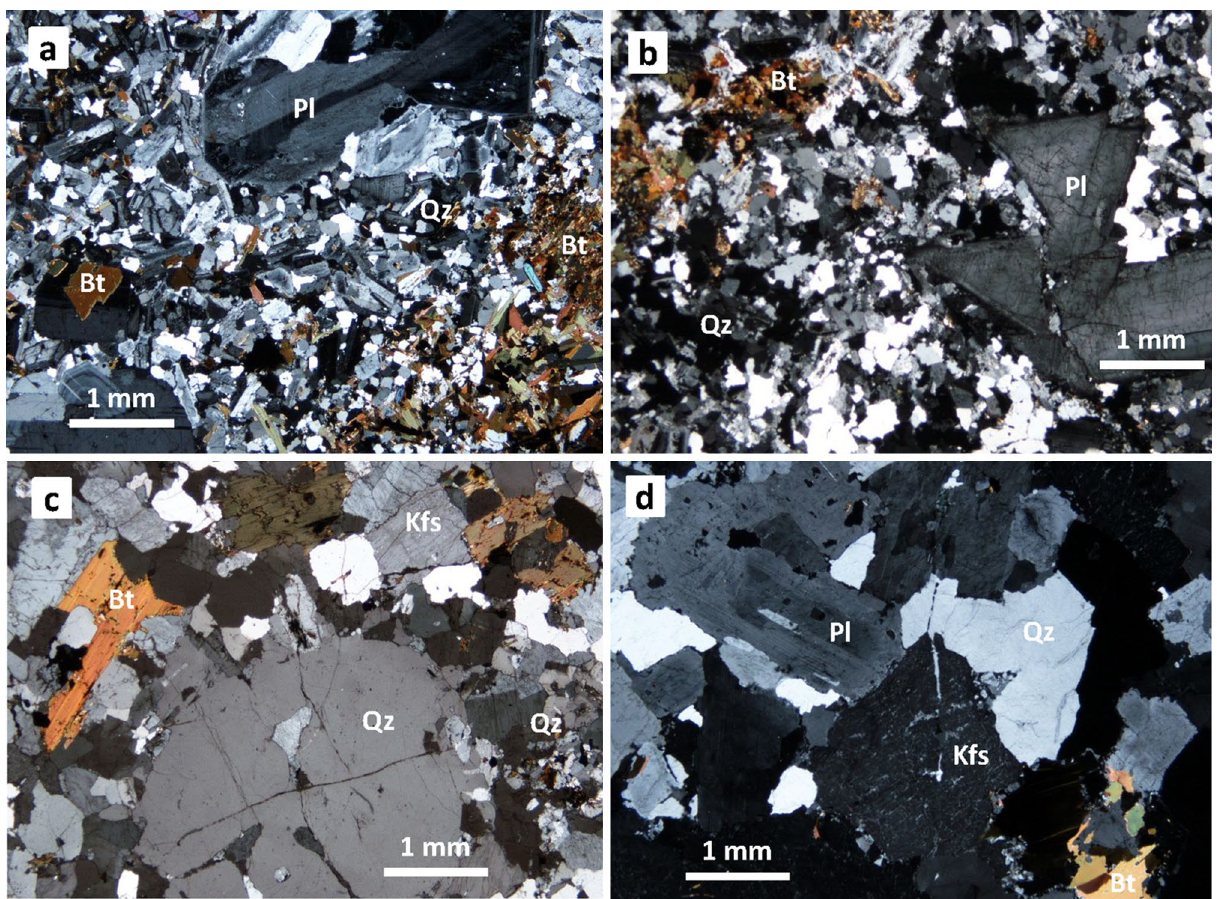
Figure 5. Photomicrographs of the Kurobegawa Granite ( a – c ) and a ~ 10 Ma granite ( d ) taken in cross- polarized light. ( a ) Typical porphyritic textures with micro crystals of quartz, plagioclase and biotite at the northwestern margin of the granite at Loc. KRB16. ( b ) Groundmass quartz shows a strong dynamic recrystallization and fracturing of a large plagioclase phenocryst near the Jiigatake Volcanics at Loc. KRB30. Many xenocrystic zircons were identified in this sample. ( c ) Groundmass quartz shows a weak dynamic recrystallization, and a quartz phenocryst shows dissolution at the south of the granite at Loc. KRB27. ( d ) Equigranular granite showing indications of neither tectonic shear nor fluid migration located to the west of the northern Kurobegawa Granite at Loc. KRB23. Qz quartz, Pl plagioclase, Bt biotite, Kfs potassium The geochronology for the remnant magma chamber that, upon cooling, eventually became Kurobegawa Granite was not so simple. Based on our new and previous ages, magmatic activity along the north-eastern margin of the pluton (dash-dot lines in Fig. 2) started between 2.2 and 2.1 Ma; ~ 0.6 million years earlier than the Jiigatake volcanic activity. Following the eruption of the Jiigatake Volcanics at 1.55 Ma, Kurobegawa magmatism migrated westward, defined by ages for the Kurobegawa Granite that become younger toward the west (blue arrows in Fig. 2). Kurobegawa magmatism continued until 0.8–0.7 Ma along the north-western margin (dashed lines in Fig. 2). The youngest ages correspond to the areas of modern high temperature (> 60 °C) hot springs unrelated to volcanic activity 34 , suggesting remnant heat from the cooling Kurobegawa Granite is likely driving hydrothermal activity. In contrast, the southern part of the Kurobegawa Granite yields ages mostly 1.4–1.0 Ma, indicating that magma chamber was replenished soon after the voluminous 1.55 Ma Jiigatake eruption and until ~ 1.0 Ma. The weighted mean of all the ages from the Kurobegawa pluton (including ~ 2 Ma portion) yields 0.99 ± 0.04 Ma (95% confidence level; MSWD = 16; n = 187) (Fig. 6). Therefore, zircon forming magmatic activity may have culminated 0.5–0.6 million years after the Jiigatake eruption in a broad sense. However, the relatively high MSWD of 16 for this age suggests it is not a single population. The probability density plot of zircon crys- tallization ages for the Kurobegawa pluton ages (Fig. 7a) has multiple age peaks, compared to the well-defined single age peak for the Jiigatake Volcanics (Fig. 7b). We have deconvoluted the peak spectra for the Kurobe- gawa pluton ages using the Unmix Ages program 35 assuming three components. If we take the grouping of zircon crystallization ages to represent timing of magma intrusion and/or reheating of pre-existing mush, the result shows that the Kurobegawa pluton experienced three magmatic pulses at 1.25 ± 0.02 Ma (fraction: 36%), 0.99 ± 0.03 Ma (35%), and 0.70 ± 0.02 Ma (29%) (Fig. 7a). A similar result is also obtained using IsoplotR’s 36 radial plot (Supplementary Fig. S8) confirming these populations of ages are robust. Although it is possible that the